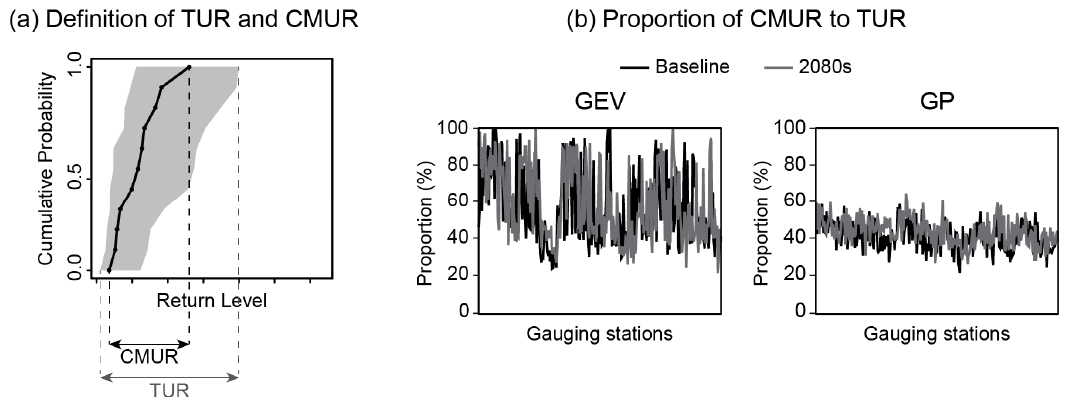
Figure 6. ( a ) Definition of the total uncertainty range (TUR) of computed 1:100 yrF value and the CM uncertainty range (CMUR). ( b ) Climate Model uncertainty range (CMUR) relative to the total uncertainty range (TUR) for the gauging stations across the UK over the baseline (black) and the 2080s (grey) computed with the GEV (left) and the GP (right).